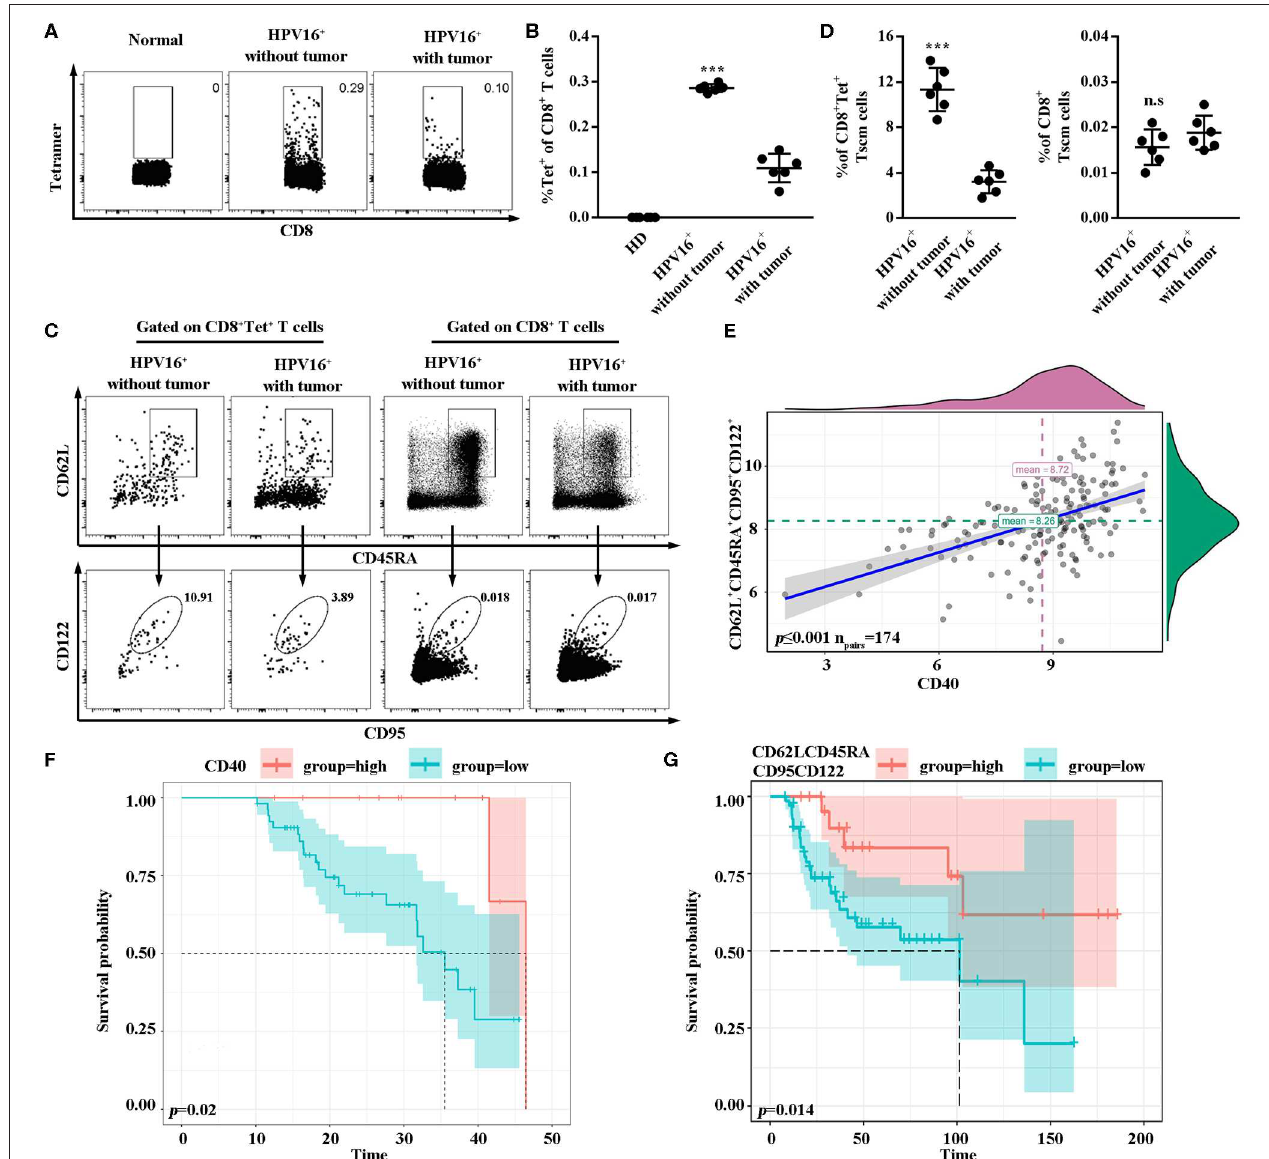
FIGURE 6 | High frequencies of Tscm might prevent the HPV infection to move on to the development of cancer. (A,B) Flow cytometry analysis of HPV16-specific CD8 + T cells in PBMC from healthy donors ( n = 6), HPV16 positive patients without tumor ( n = 6) and HPV16 positive patients with cervical cancer ( n = 6). (C) HPV16-specific or non-specific CD8 Tscm cells defined as CD45RA + CD62L + CD95 + CD122 + from CD8 + or CD8 + Tet + T cells in PBMC from HPV16 positive patients without or with cervical cancer were examined by flow cytometry. (D) The frequency of specific and non-specific CD8 Tscm cells in PBMC from HPV16 positive patients without tumor ( n = 6) and HPV16 positive patients with cervical cancer ( n = 6). (E) Relationship between CD40 and CD62L + CD45RA + CD95 + CD122 + were shown (n pairs = 174). (F,G) K-M plots of HPV16 positive patients with cervical cancer for CD40 (F) and CD62LCD45RACD95CD122 (G) respectively. Error bars represent the mean ± SD of three independent experiments. *** p < 0.001; n.s, p >0.05.